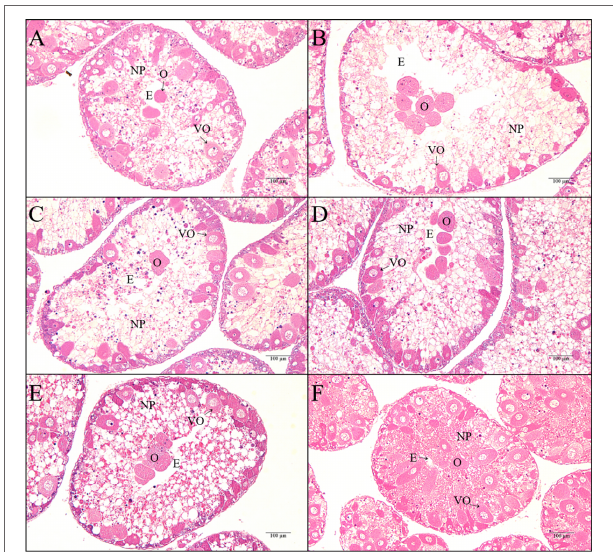
FIGURE 1 | Histology observations in the ovaries of female adult sea urchin ( Strongylocentrotus intermedius ) fed diets with different lipid sources (colza oil (CO), fish oil (FO), linseed oil (LO), soybean oil (SO), or palm oil (PO)). (A) Colza oil, stage V; (B) Fish oil, stage V; (C) Linseed oil, stage V; (D) Soybean oil, stage V; (E) Palm oil, stage V; (F) Feed kelp, stage V. NP, nutritive phagocyte. VO, vitellogenic oocyte. O, ova. E, empty spaces.